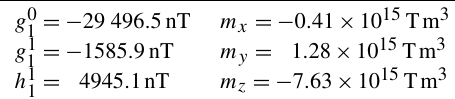
Table 1. Dipole coefficients of the IGRF in 2010. On the left side are the Gauss coefficients according to Finlay et al. (2010). On the right side are the corresponding dipole vectors using Eq. (3). = − 29 496 . g 0 1